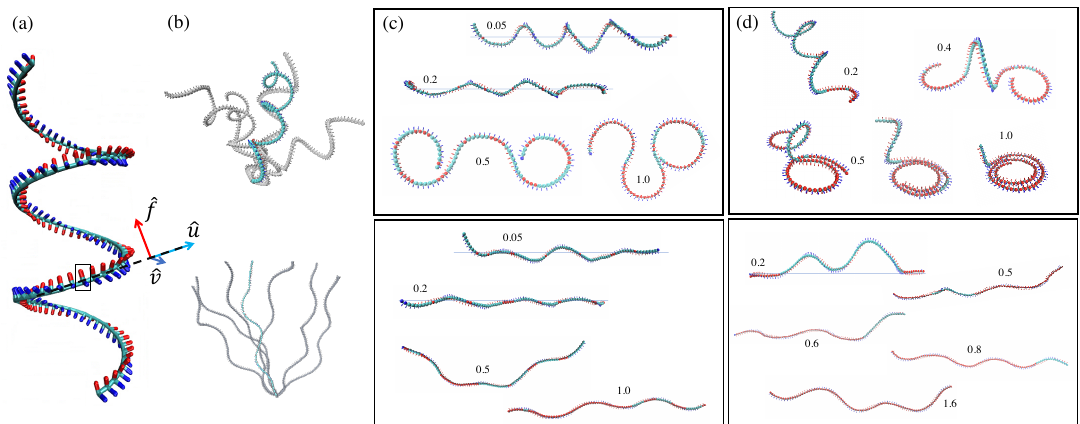
Figure 1. Various shapes of super-Helical filaments. ( a ) The helical shape of the ground state conformation of H-filaments ( ω 1 = 0.81 σ − 1 , ω 2 = 0, and ω 3 = 0.10 σ − 1 ). The local twist and curvature are represented by a set of orthogonal vectors { (cid:126) u , (cid:126) f , (cid:126) v } along the filament backbone. (cid:126) f , (cid:126) v are defined in the material frame orthogonal to the local tangent vector (cid:126) u . Top panels in ( b – d ) show H-filaments with γ > 1, ( ω 1 = 0.81 σ − 1 , ω 2 = 0, and ω 3 = 0.10 σ − 1 ), where circular shapes are ground states when squeezed. Bottom panels in ( b – d ) show H-filaments with γ < 1, ( ω 1 = 0.09 σ − 1 , ω 2 = 0, and ω 3 = 0.19 σ − 1 ), where wavy shapes are ground states when squeezed. The localized parts of H-filaments ( | z | < 0.2 σ ) are shown in red. ( b ) Bulk conformations subject to thermal fluctuations. kz 2 and ( d ) adsorbed ( c ) Typical conformations of H-filaments confined by harmonic potential V ( z ) = 1 2 under a localized surface potential U ads ( z ) = 4 (cid:101) [( σ / z ) 12 − ( σ / z ) 6 ] . The numbers are the strength of harmonic potential k and the surface potential (cid:101) . The figures with horizontal lines indicating the line of z = 0 are side views. The flexural modulus B = 50 σ k B T and twist modulus C = B